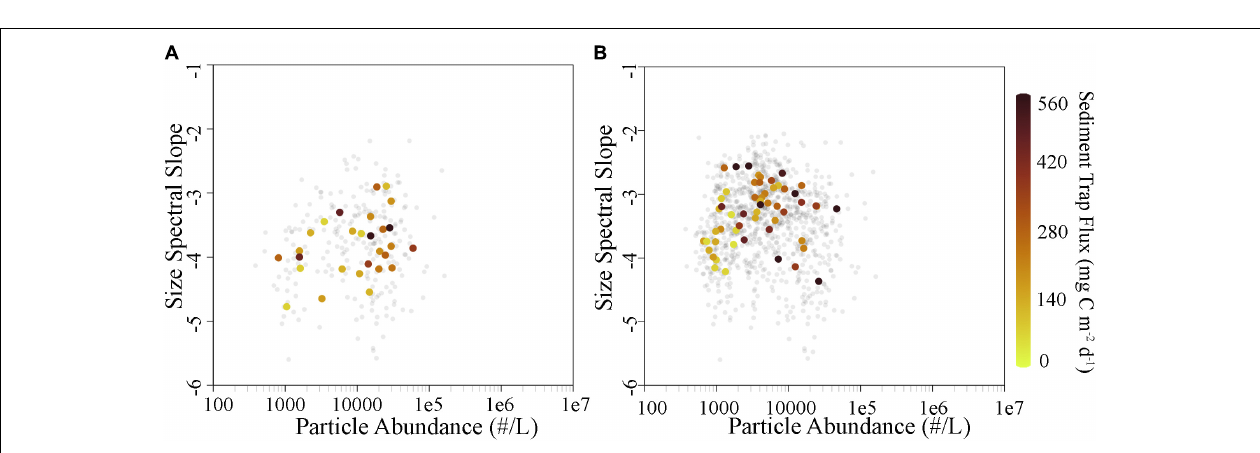
FIGURE 3 | Comparison of flux estimates derived from sediment trap deployments and UVP algorithms using parameter values from (A) Guidi et al. (2008) and (B) Iversen et al. (2010) with shaded areas as the 95% confidence interval of an OLS regression determined via non-parametric bootstrapping. Each point is cycle averaged. Colors indicate vertically integrated NPP. Gray dashed lines are